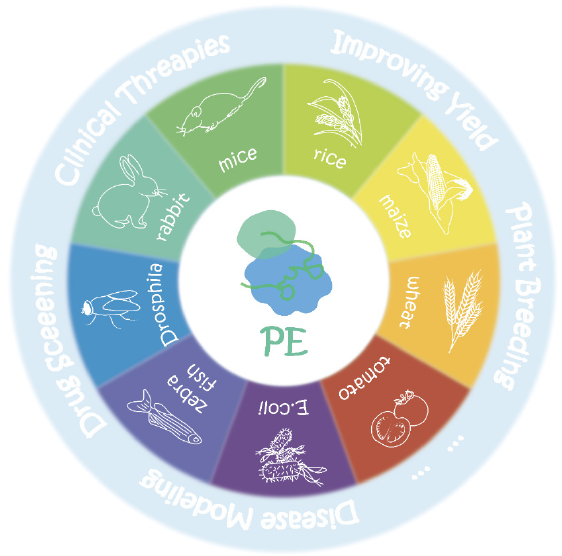
Figure 3. Applications of PE in different species. Current transformative application attempts of PE in various fields, such as clinical medicine, agriculture, and so